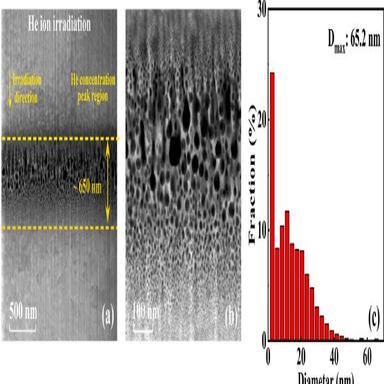
Cross-sectional TEM images of He concentration peak region at different magnifications for individual He-irradiated Cu sample.